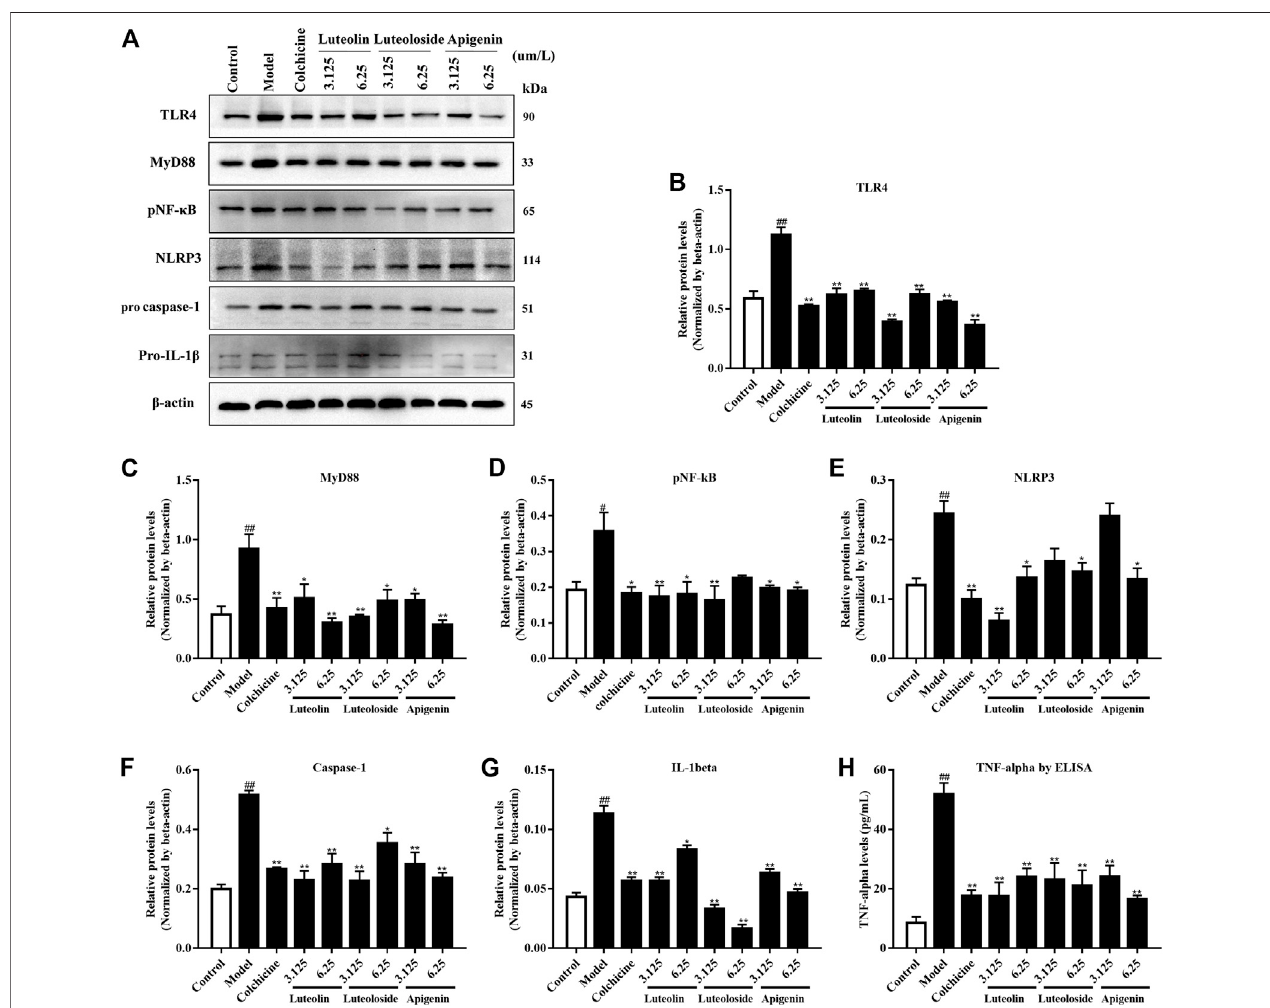
FIGURE 4 | The effects of the active fl avonoids luteolin, luteoloside, and apigenin on the TLRs/MyD88/NF- κ B pathway, NLRP3/caspase-1/IL-1 β expression, and TNF- α levelsinMSUcrystal-inducedRaw264.7cells( n (cid:2) 4).Therepresentativewesternbandsareshowninpanel (A) .ThechangesinTLR4 (B) ,MyD88 (C) ,pNF- κ B (D) , NLRfamilypyrindomain-containing3(NLRP3) (E) ,procaspase-1 (F) ,andpro-IL-1 β (G) areshownashistograms. (H) TNF- α levelsbyELISAassay. # p < 0.05and ## p < 0.01 vs. control group; * p < 0.05 and ** p < 0.01 vs. model